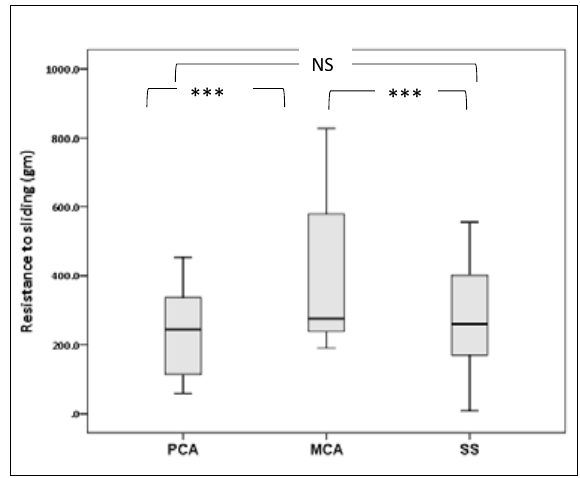
Figure 2. Box plot graph of the overall frictional resistance among bracket groups (dry environment). (PCA) polycrystalline alumina brackets. (MCA) monocrystalline